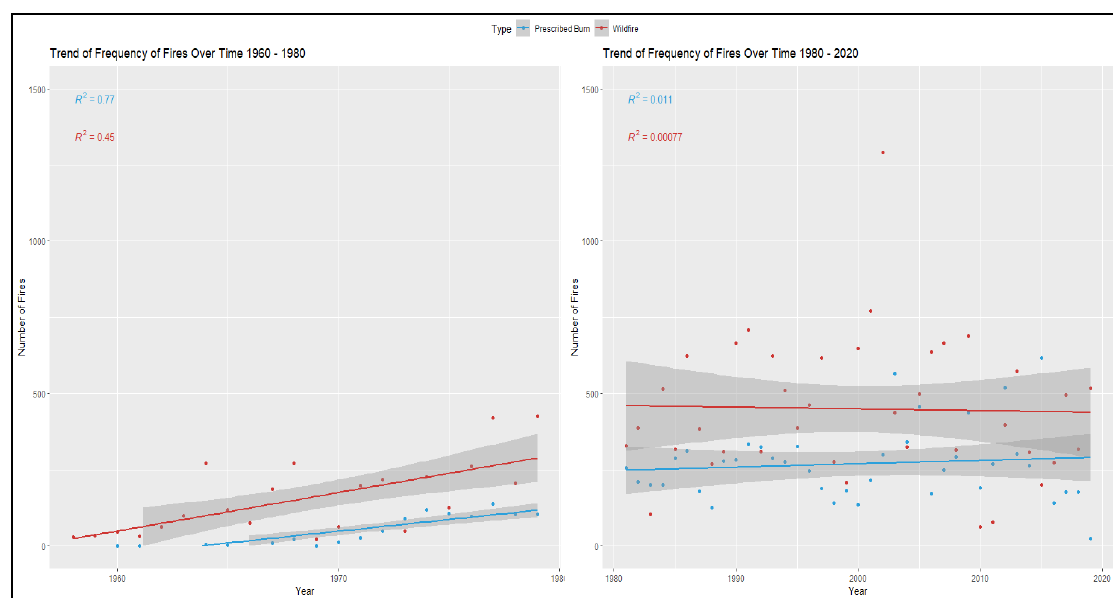
Figure 10. Increase in the frequency of fires over time.